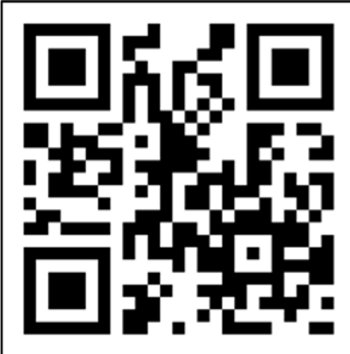
Figure 17. QR code that opens a web browser.